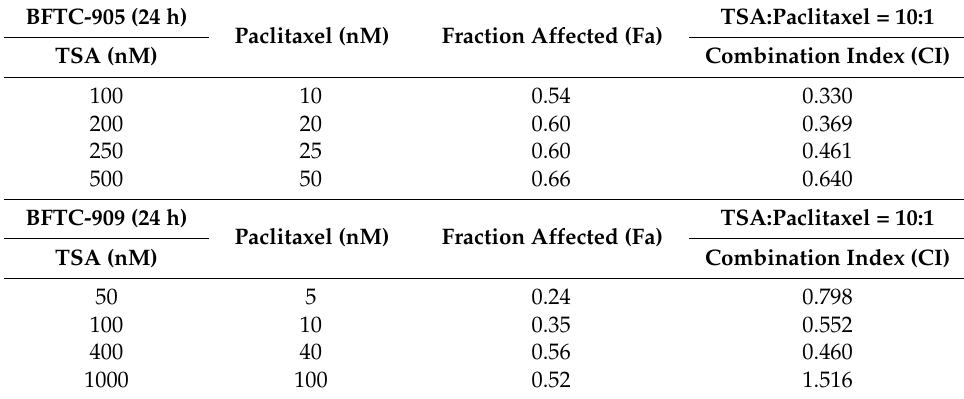
Figure 3. Combination indexes (CIs). Synergistic effects were confirmed through cell viability assay ( n = 4), and the results were calculated in CalcuSyn. TSA and paclitaxel were at a 10:1 concentration ratio. CIs are presented in the CI–effect plot (as log 10 CI ± SD). CI values <1, =1, and >1 were defined as synergistic, additive, and antagonistic effects, respectively. Table 1. CI. Combination consistently exhibited synergistic effects (CI < 1) in terms of reducing viability in BFTC-905 and BFTC-909 cells.